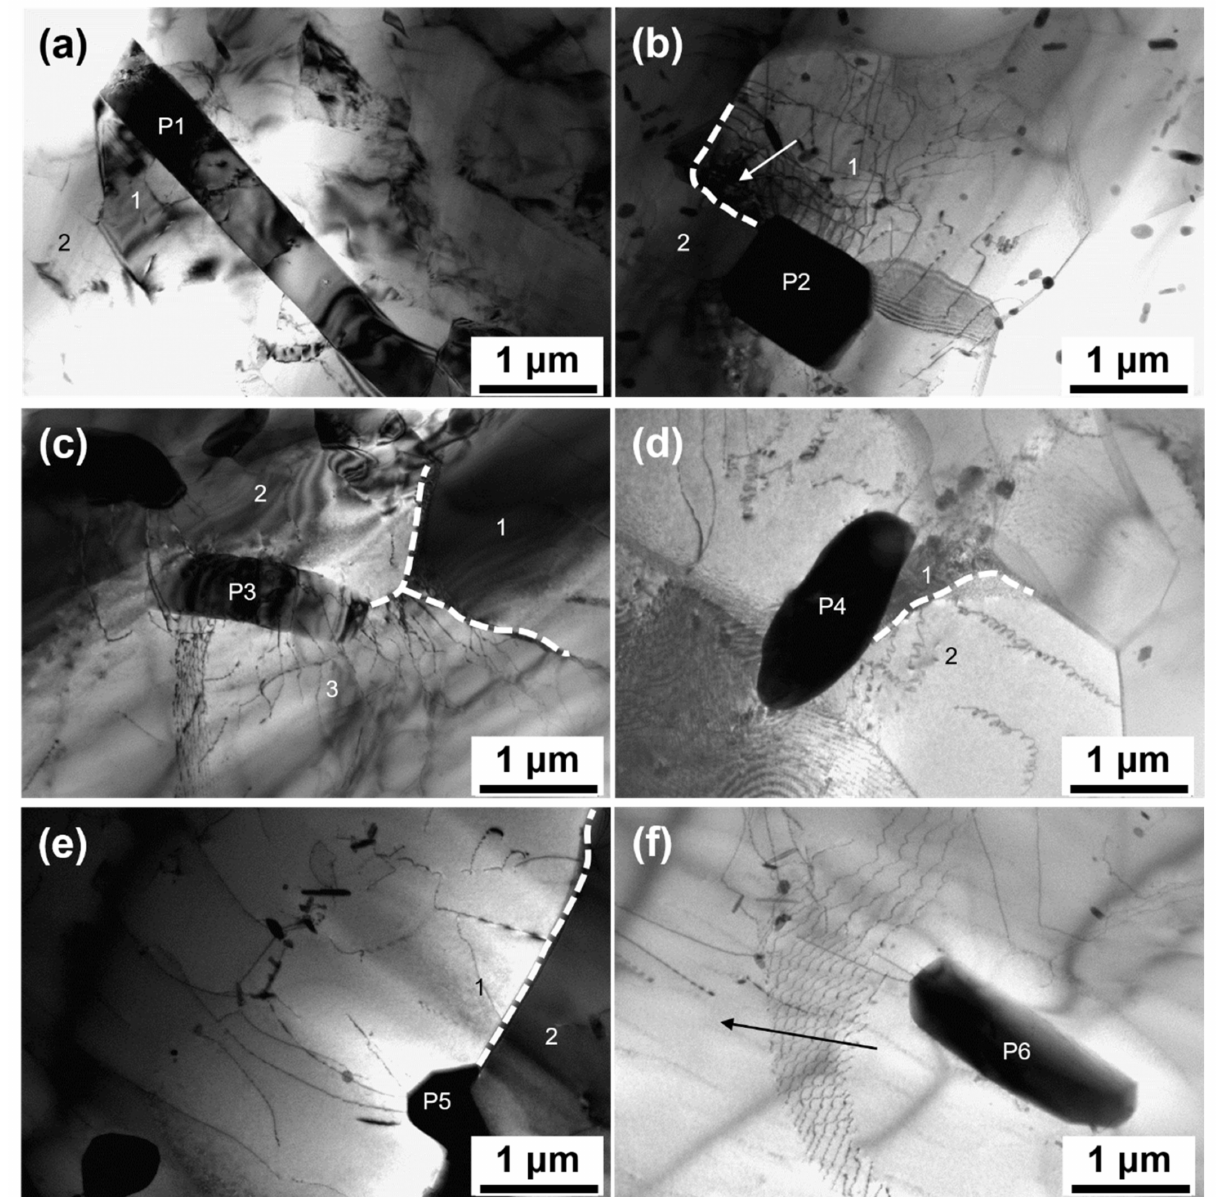
Figure 7. TEM images of interaction between dislocation and second phase of spray-deposited 7055 aluminum alloy under hot compression conditions of 300 ◦ C/5 s − 1 ( a ), 300 ◦ C/0.001 s − 1 ( b ), 400 ◦ C/0.1 s − 1 ( c ), 450 ◦ C/5 s − 1 ( d ) and 450 ◦ C/0.001 s − 1 ( e , f ); P i (i = 1~6) represents the particles that remained after hot